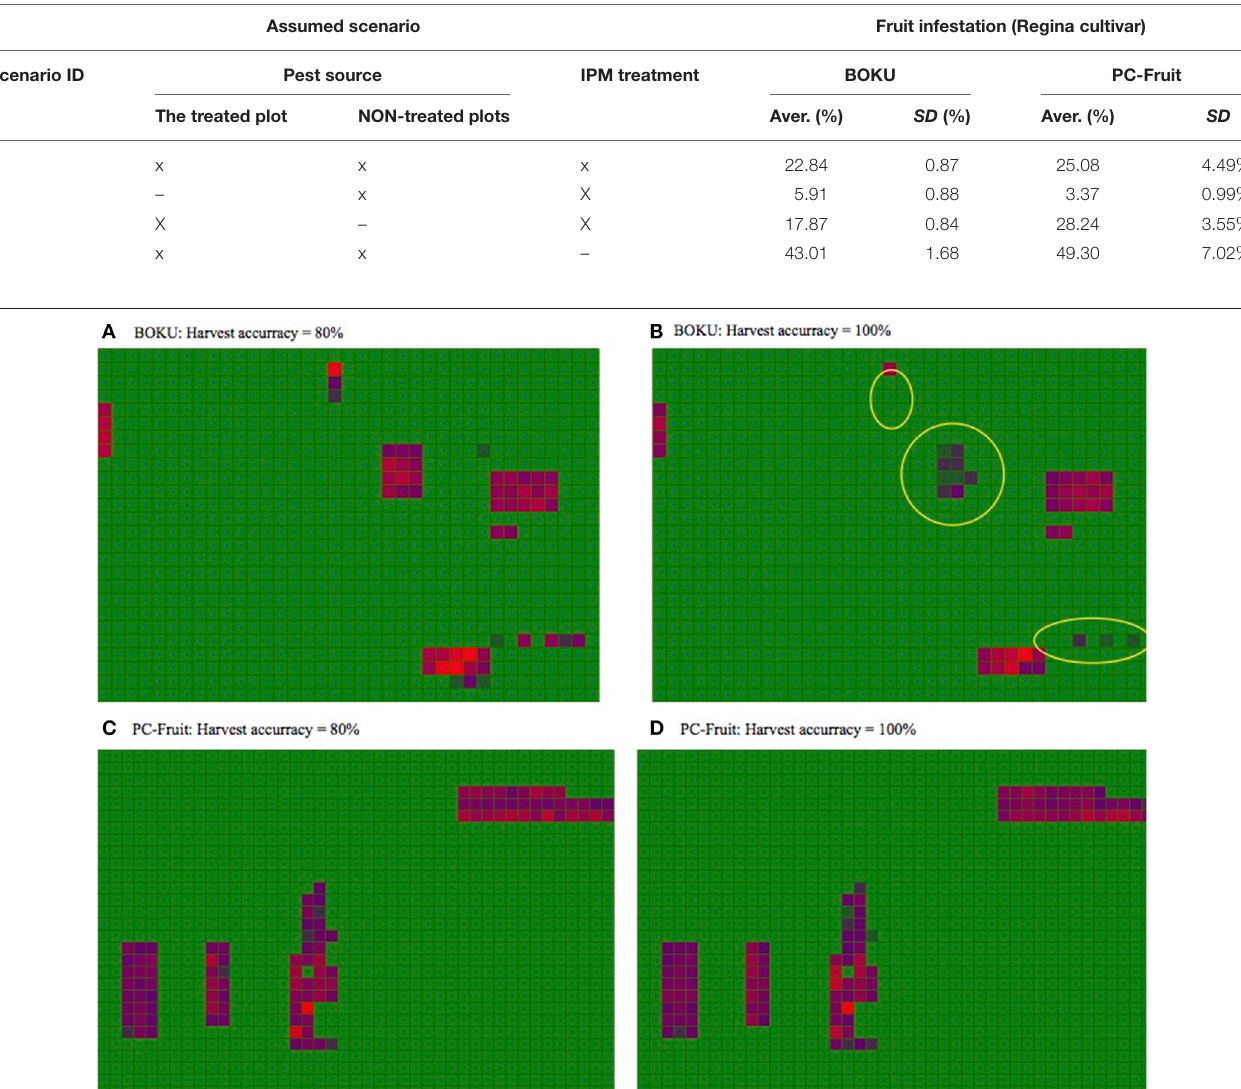
TABLE 6 | Contribution of various pest sources to the post-treatment population resurgence.